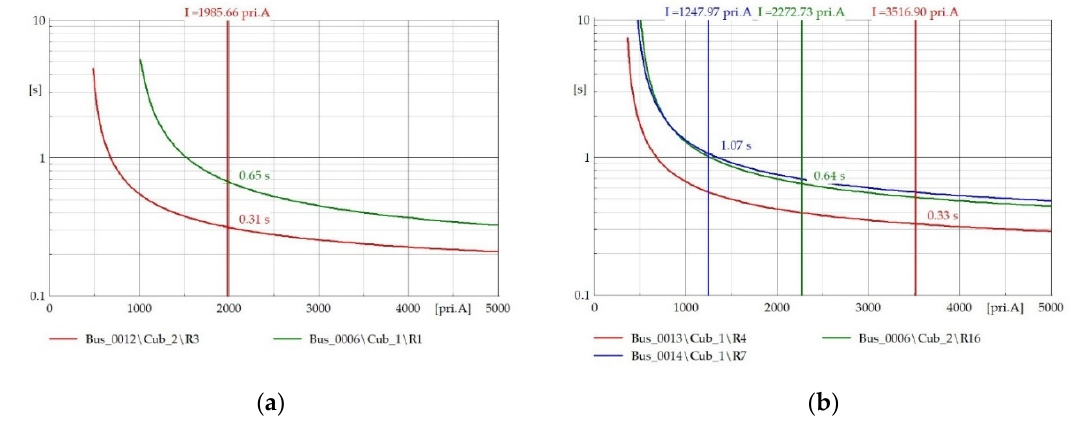
Figure 10. ( a ) T 14, R3 (red) primary operation with backup R1 (green) obtained with cluster 4 settings; ( b ) T14, R4 (red) primary operation with backup R16 (green) and R7 (blue) obtained with cluster 4 settings.